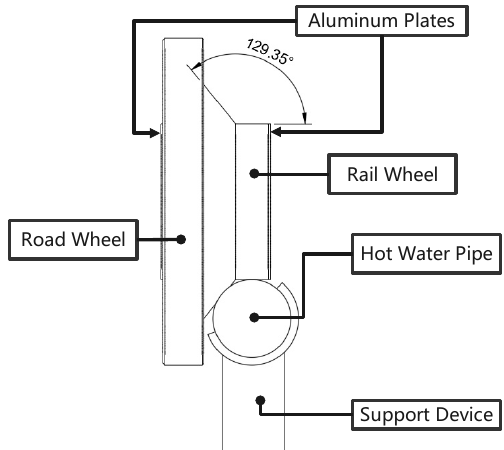
Figure 8. Cross-sectional view of the wheel and the hot water pipe. This design allows the wheel to maintain some clearance from the hot water pipe to avoid collision with the support